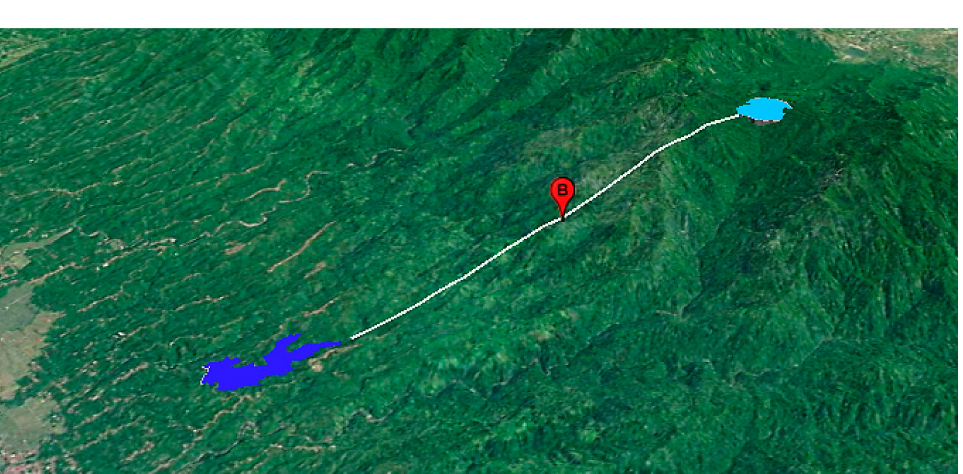
Figure 7. Site of 50 GWh PHES in Jembrana Regency, Bali Province, Indonesia (8.30271 ◦ S, 114.77750 ◦ E). Image from NationalMap [18] and original data from the Australian National Univer- sity Global Pumped Hydro Atlas [17].